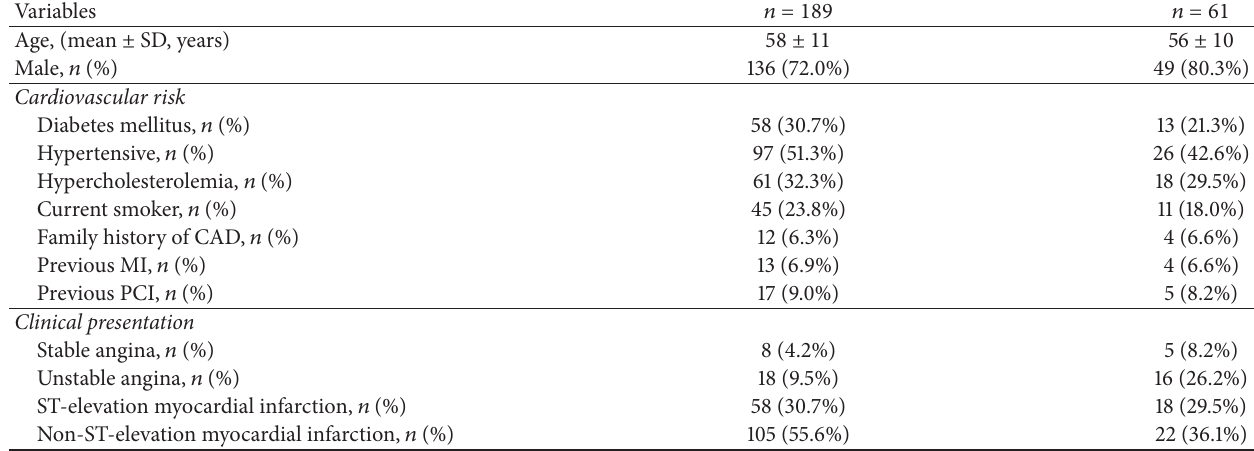
Table 1: Baseline clinical characteristics for the entire population ( 𝑛 = 189 ) and for patients undergoing examination by quantitative coronary angiography ( 𝑛 = 61 ) at 9 months.